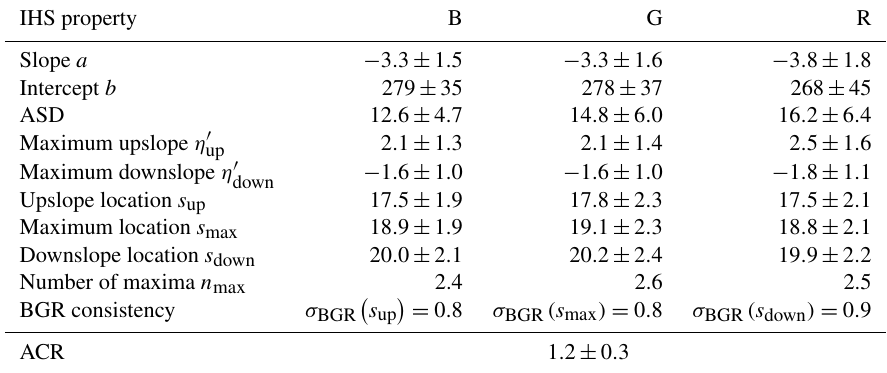
Figure 6. The 1d example for PSTS and IHS (SGP 10 March 2018). Sample TSI images are included. The middle panel shows PSTS versus time of day (N/A excluded). Bottom panel shows the IHS versus time; w = 3 . 5min. All times in UTC. Table 4. Discriminant properties used for the ice halo score. Averages and standard deviations for a training set of 188 quadrant records are listed. All units are based on color intensity values and LSM